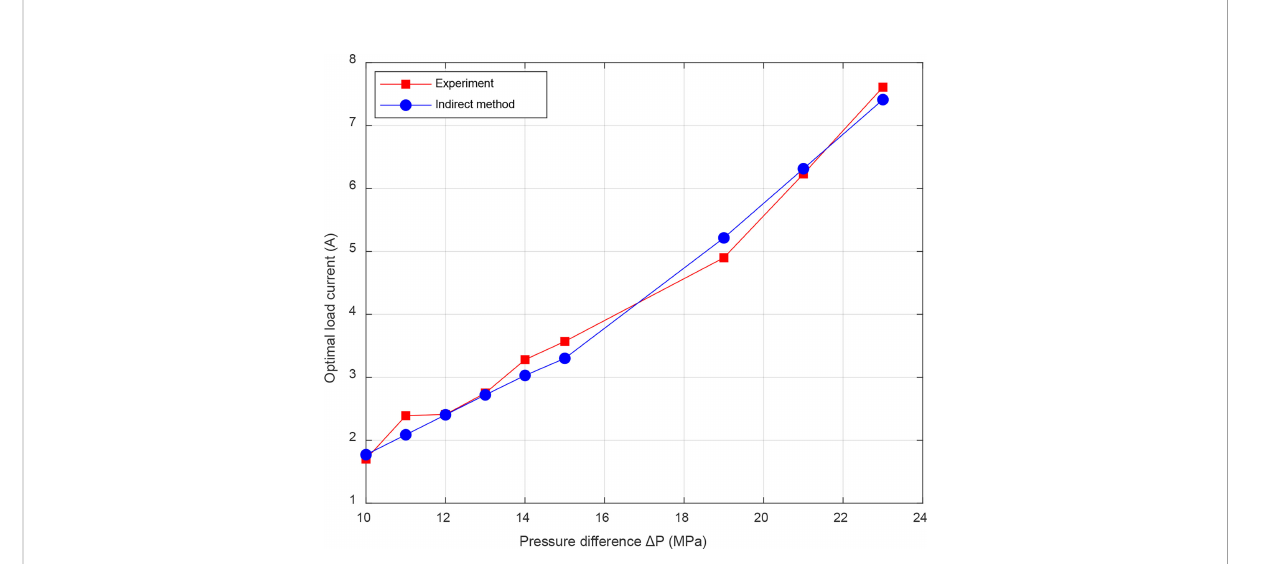
FIGURE 13 The simulation and experimental comparison of the optimal load current.